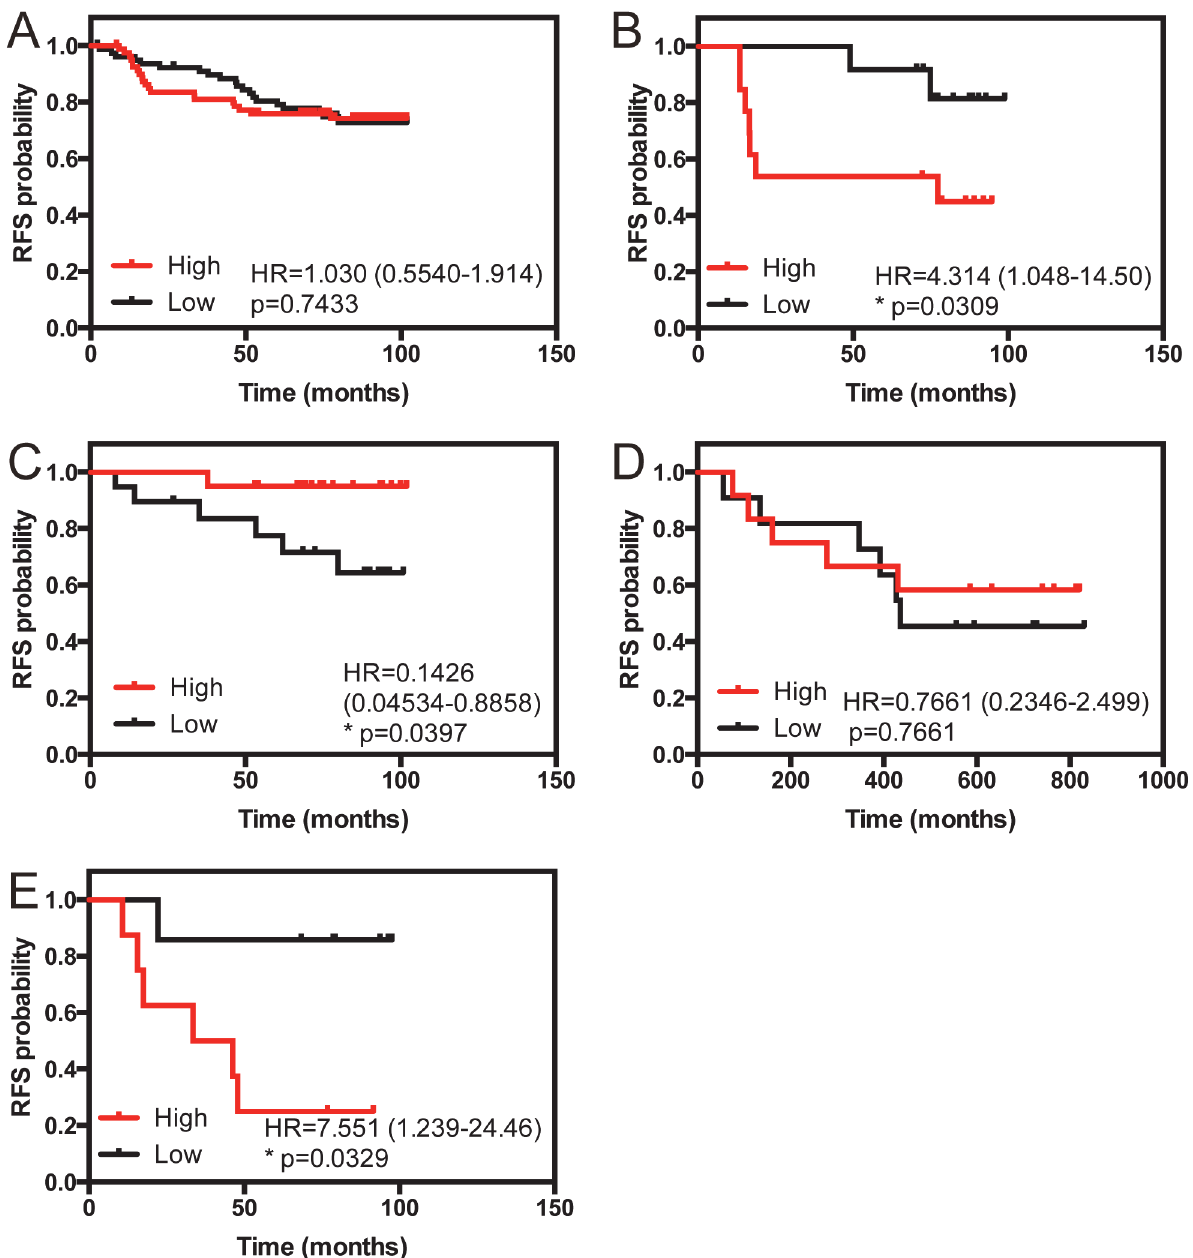
Fig 2. Overexpression of LSD1 is linked to poor outcome in basal-like breast cancer. Effect of LSD1 overexpression (as defined by scores > median) on recurrence free survival (RFS) across all or for each subtype of breast cancer are shown (overall breast cancer, n = 159 (A), basal-like, n = 25 (B), luminal A, n = 39 (C), luminal B, n = 23 (D) and HER2, n = 15 (E)). Overexpression of LSD1 transcripts shows significant shorter RFS in basal-like or HER2 type breast cancer (p = 0.0309, p = 0.0329, respectively). P-value was calculated using Gehan-Breslow-Wilcoxon